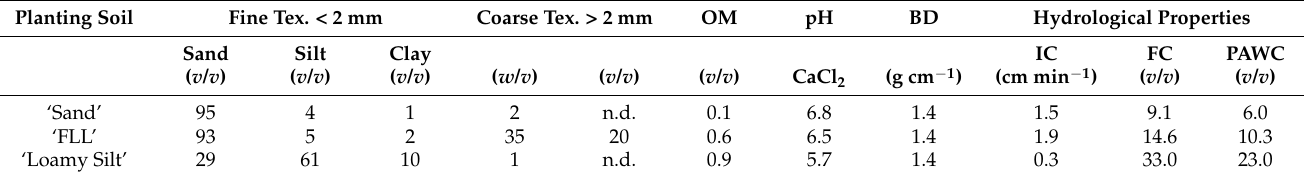
Table 2. Soil properties of the three planting soils with OM as the organic matter content, BD as the bulk density, IC as the infiltration capacity, FC as the field capacity, and PAWC as the plant available water